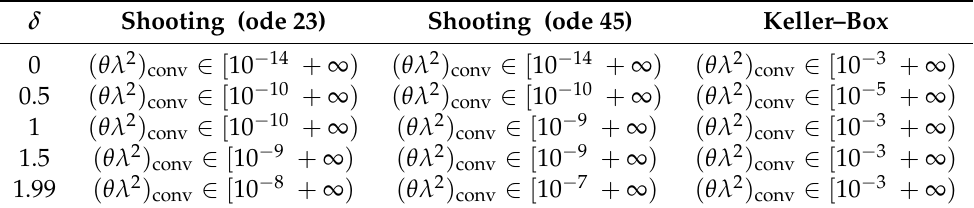
Table 1. Ranges of θλ 2 ensuring convergence (shooting and Keller–Box